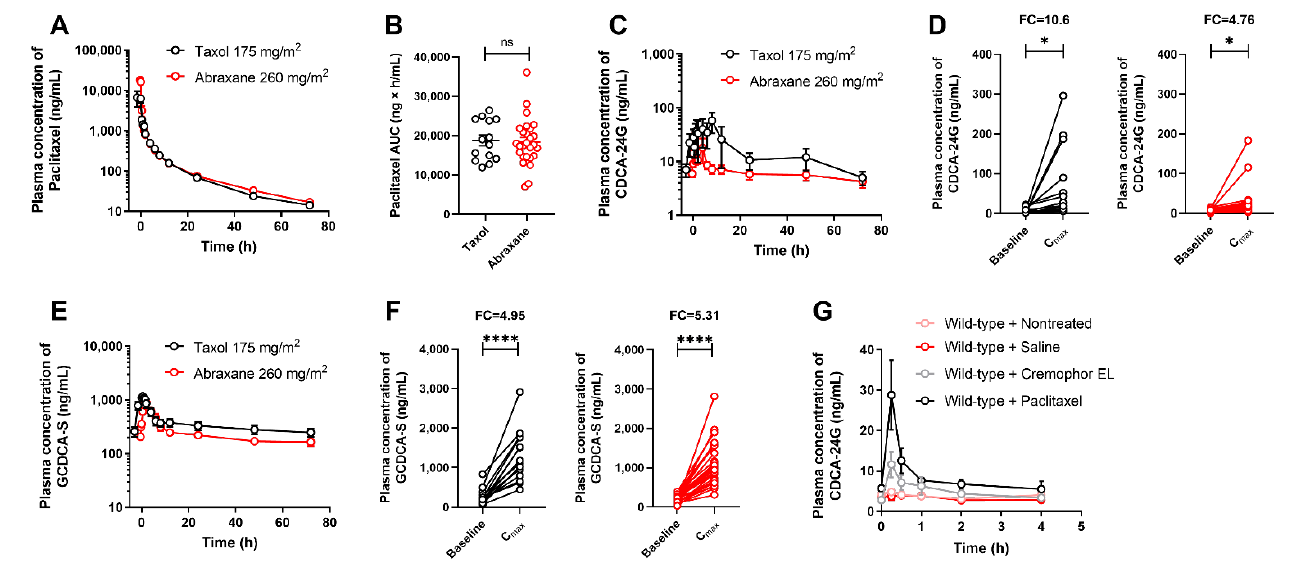
Figure 4. Influence of paclitaxel formulation on OATP1B biomarkers. ( A ) Plasma concentrations of paclitaxel and ( B ) AUC of paclitaxel in patients after i.v. infusion of Taxol (175 mg/m 2 ) or Abraxane (260 mg/m 2 ). ( C ) Plasma concentrations of CDCA-24G, ( D ) plasma concentration of CDCA-24G at baseline and C max in patients receiving Taxol or Abraxane. ( E ) Plasma concentrations of GCDCA-S, ( F ) plasma concentration of GCDCA-S at baseline and C max in patients receiving Taxol or Abraxane, * p < 0.05; **** p < 0.0001, ( n = 13–26). ( G ) Plasma concentrations of CDCA-24G in untreated wild-type mice, or after receiving saline (5 mL/kg, i.v.), Cremophor EL/ethanol (1:1, v / v , 5 mL/kg, i.v.), or paclitaxel (Taxol; 10 mg/kg, 5 mL/kg, i.v.), ( n = 3–5 per group). All data are presented as mean ± SEM.